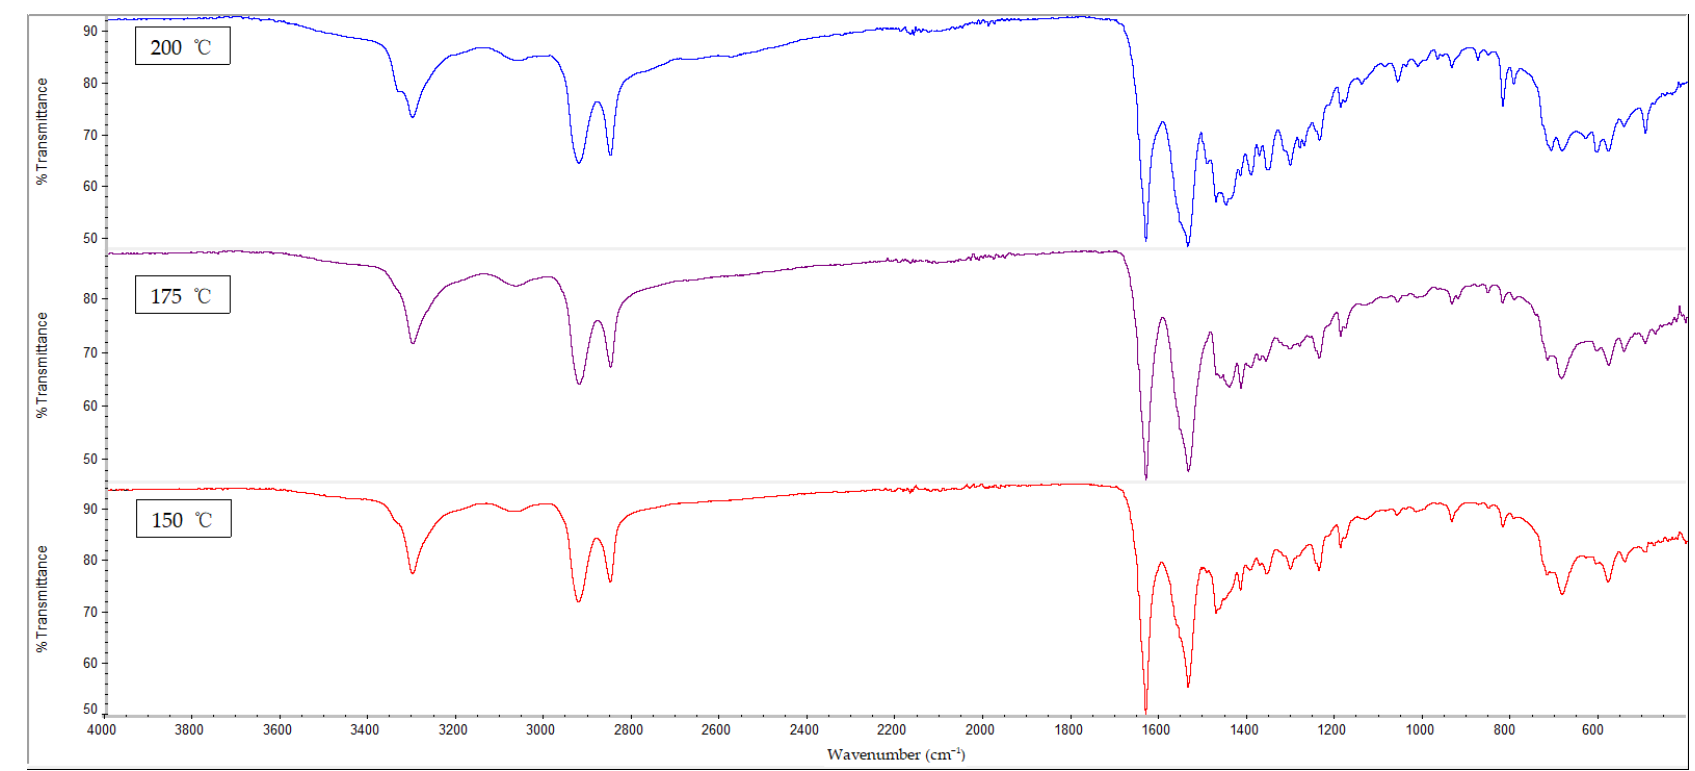
Figure 14. FTIR Spectra for Nylon 610 Nanocomposites with 2.5 wt% Treated Graphite Flakes at All Temperatures.